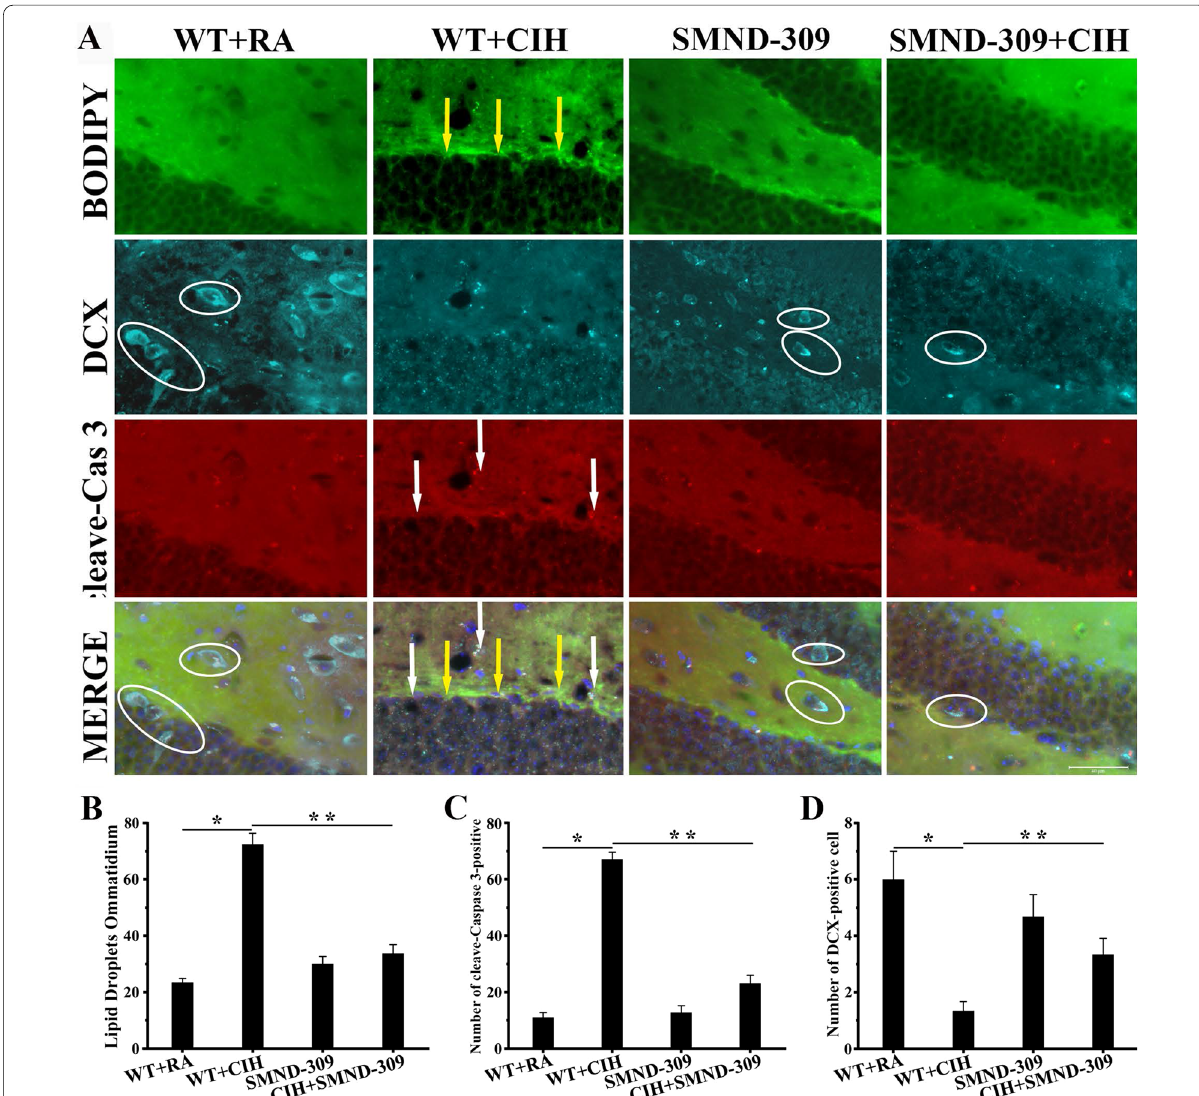
Fig. 6 LDs accumulation-induced NBs apoptosis. Fluorescent immunocytochemistry staining was as follows: NB marker DCX (sky blue), cleaved caspase 3 (red), BODIPY (483/503) (green) and DAPI (blue). A Seldom DCX-positive cells (blue, white circle) in the SGZ of WT CIH mice could be + observed. Moreover, a larger number of BODIPY (483/503) (green, yellow arrow) and cleaved caspase 3-positive cells (red, white arrow) merged. SMND-309 treatment ameliorated these injuries. B Quantification of LDs accumulation. C Quantification of cleaved caspase 3-positive cell. D Quantification of DCX-positive cell. *p < 0.05 WT group vs. WT CIH group. **p < 0.05 WT CIH group vs. SMND-309 CIH group. All experiments were repeated three times. Data are shown as the mean SEM. Statistical analysis was performed with two-way ANOVA. Original magnification: 600 ±